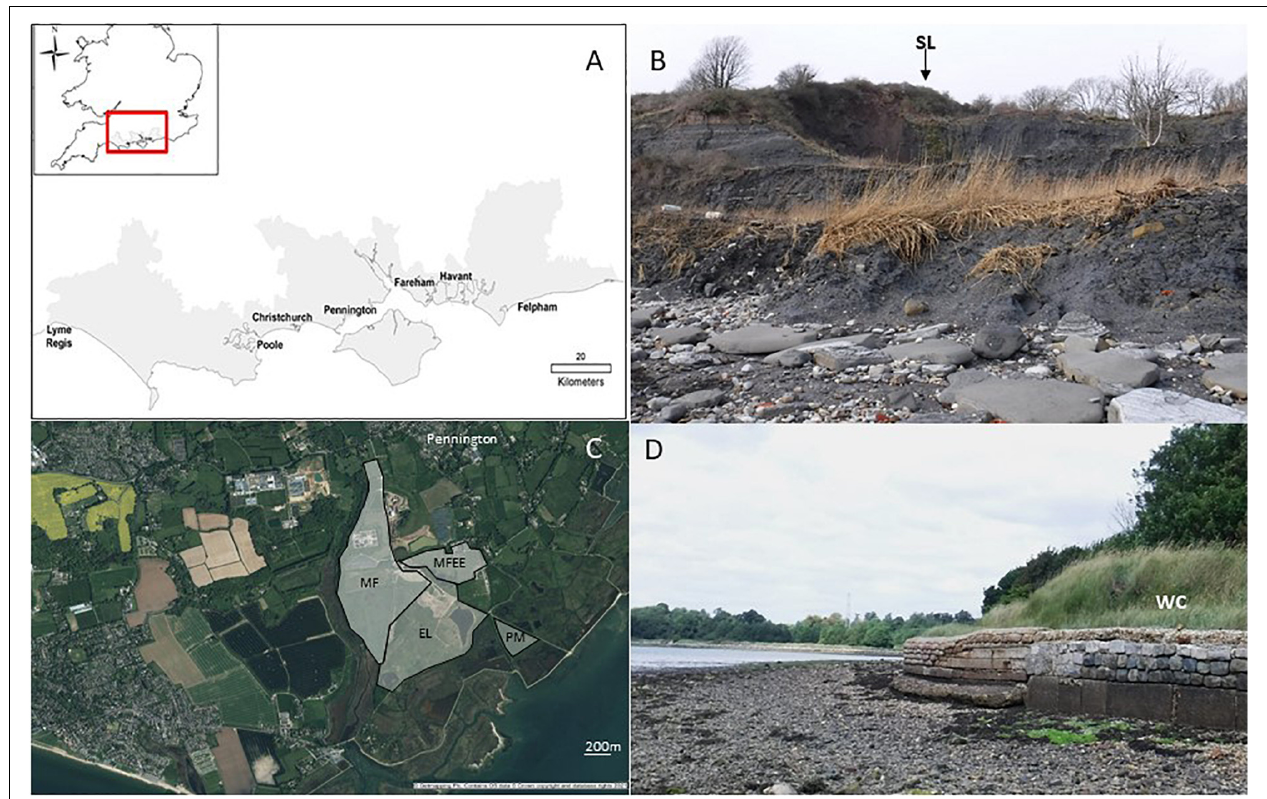
FIGURE 3 | (A) Location of study sites in England, highlighted is the region assessed by Wadey et al. (2019) and the locations of the case study areas referred to in Column 1 of Table 1 . (B) View from the beach below Spittles Lane landfill site (SL), Lyme Regis. (C) Aerial photograph showing the location of Pennington Marshes landfill (PM), and the larger more landward landfill complex at Pennington comprising three landfills –EL, Efford Landfill; MF, Manor Farm Landfill; and MFEE, Manor Farm Eastern Extension. © Getmapping Plc. Contains OS data. © Crown copyright and database rights 2021. (D) View showing the informal coastal defenses of Wicor Cams landfill (WC) and foreshore, Fareham. Photographs B and D courtesy of Anne Stringfellow.